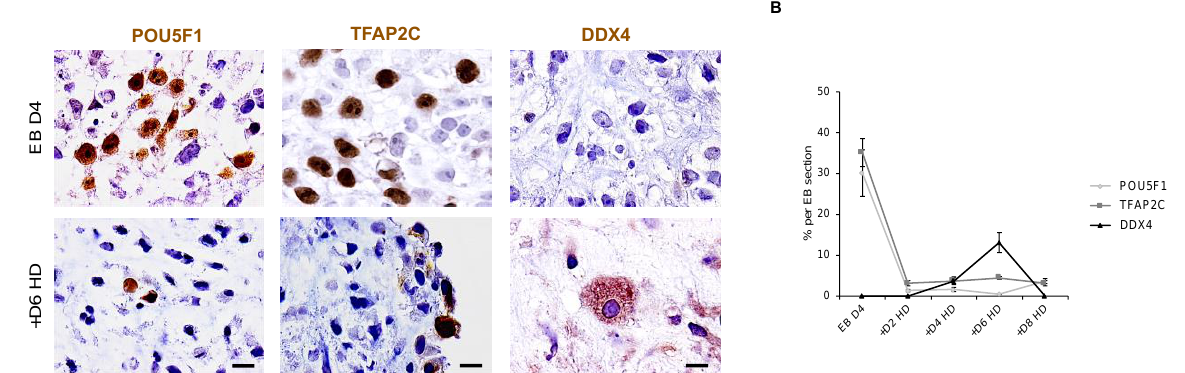
Figure 8. Assessment of kinetic expression of pluripotency, early PGC and late PGC protein markers in embryoid bodies before and after hanging drop culture. ( A ) Immunodetection of POU5F1, TFAP2C, PDPN and DDX4-positive cells in day 4 or day 10 embryoid bodies. All images are at a ×1000 magnification with a scale bar of 10 µm. ( B ) Percentages of POU5F1, TFAP2C, PDPN and DDX4-positive cells per embryoid body section at days 4, 6, 8, 10 and 12. The results are presented as the mean ± sem., with n = 3. Conditions that do not share a common letter are significantly different ( p < 0.05). +D2 HD: +Day 2 in Hanging drop; EB D4: Embryoid Body at Day 4.